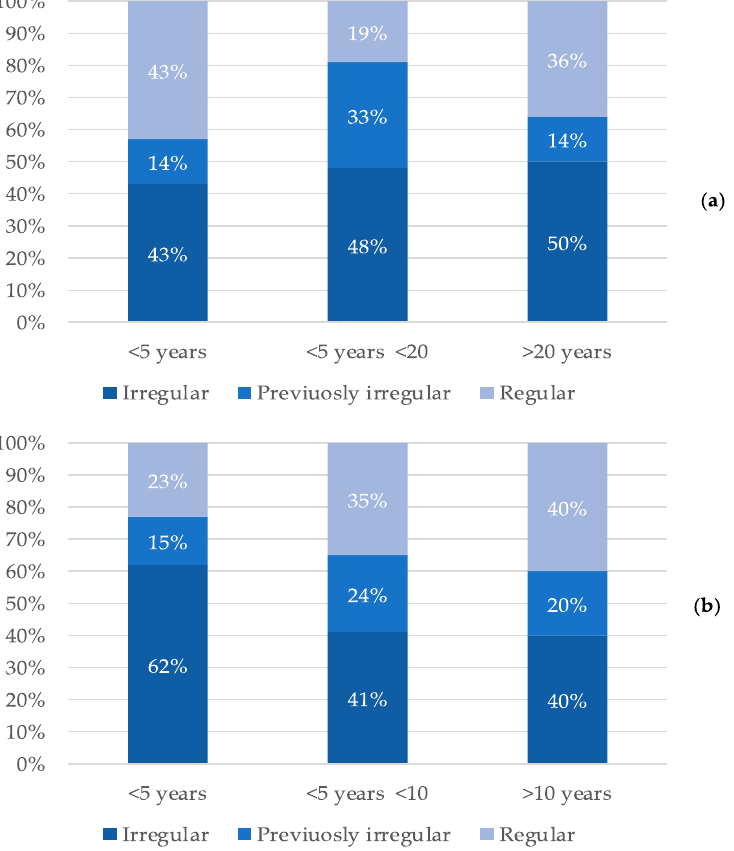
Figure 3. Behavior of patients in the management of diabetes as a function of the time elapsed since the diagnosis of diabetes ( a ) and DME ( b ).